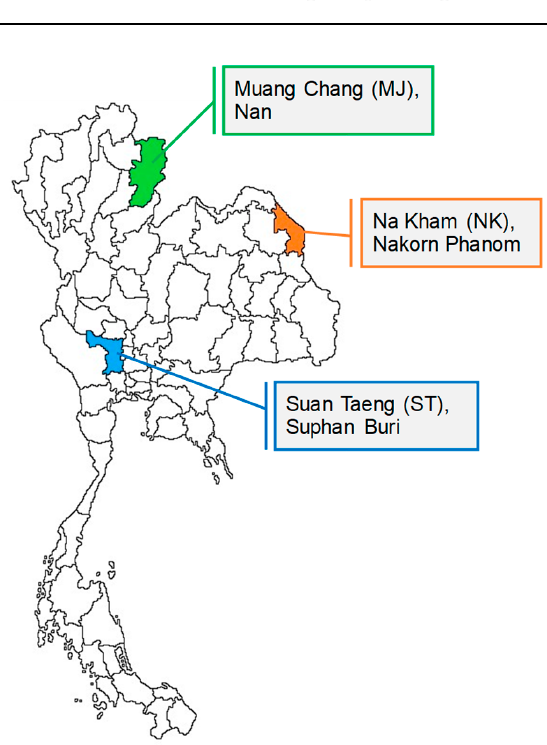
Figure 2. Study site locations.